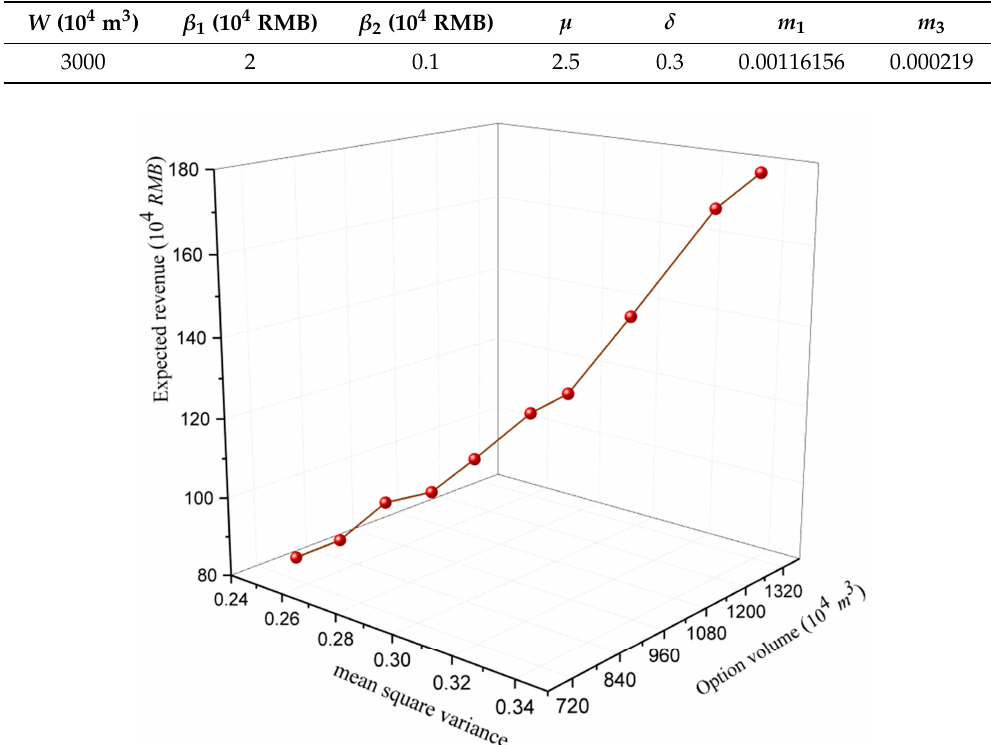
Table 2. Model parameters of experiment scheme 1.